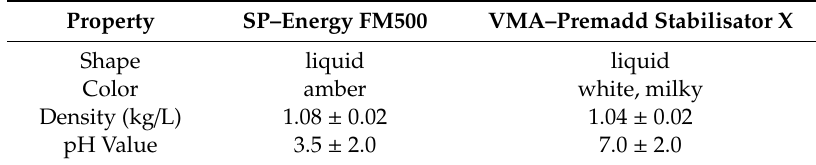
Table 3. Properties of superplasticizer (SP) and viscosity-modifying admixture